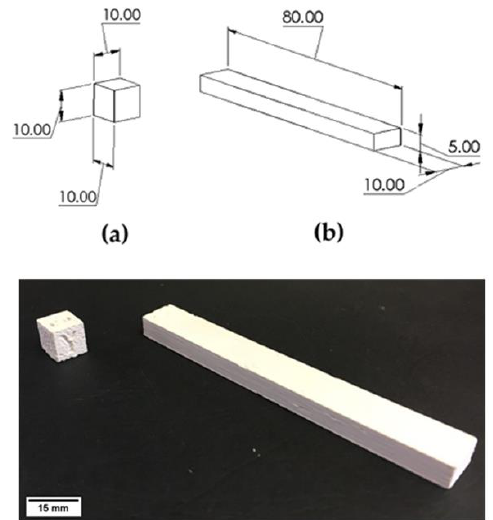
Figure 2. Sample sketch with nominal dimensions in mm ( top ) and 3D-printed samples ( bottom ): ( a ) cubes; ( b ) flexural samples.